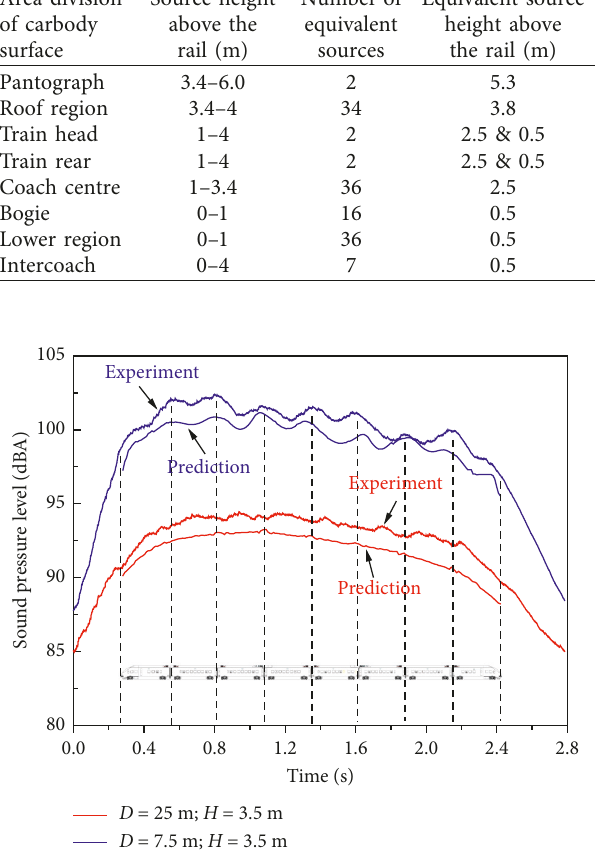
Figure 14: Time histories of the predicted and measured pass-by noises at